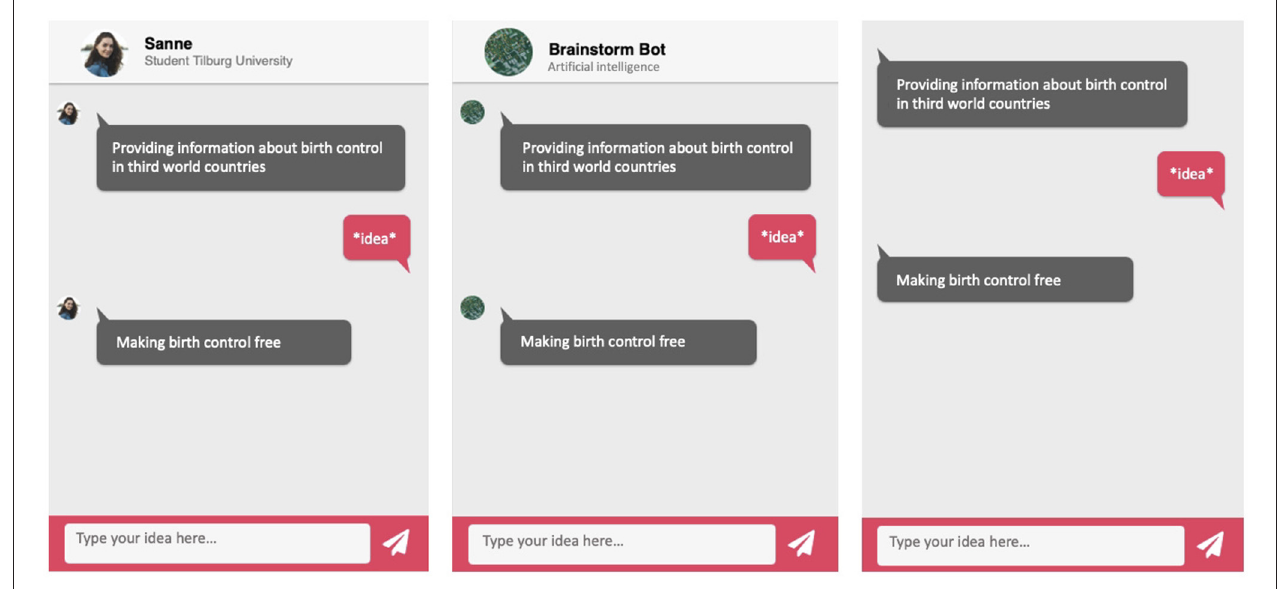
FIGURE 1 | The manipulations of the chat